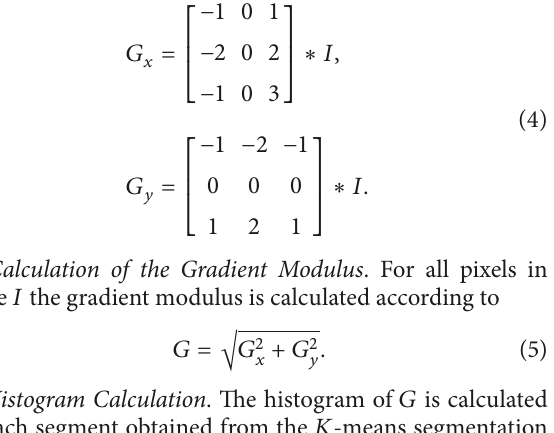
descriptor corresponds to the histogram of the gray values of the segment. The histogram is configured with 10 bins and each bin is normalized with the amount of pixels that the segment contains. This generates a 10-dimensional vector where each dimension has values in the interval [ 0 , 1 ].